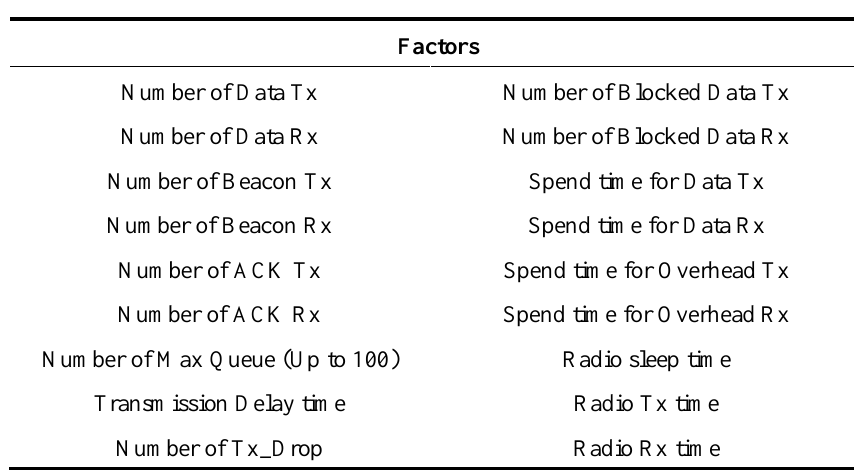
Table 8. Various factors.